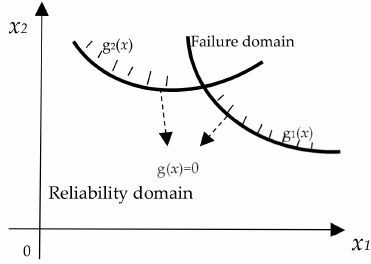
Figure 10. Failure surfaces of the series systems.